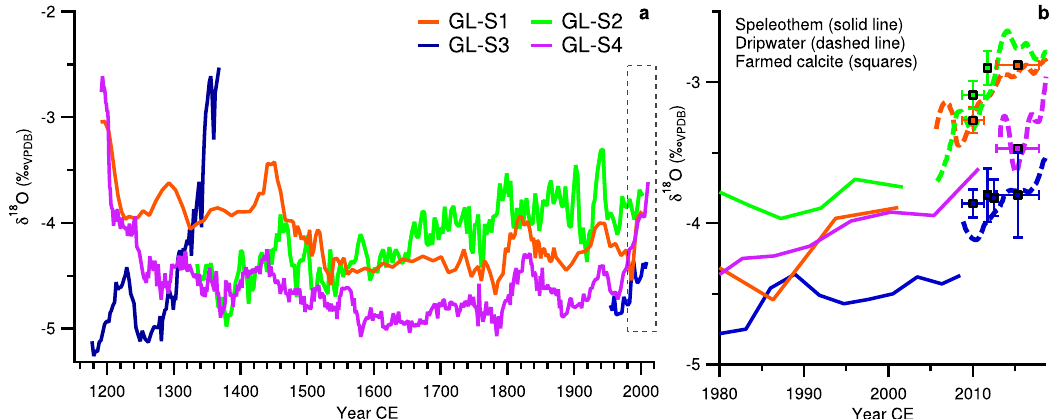
Fig. 4 Golgotha Cave speleothem δ 18 O records. a Speleothem records GL-S1 (red), GL-S2 (green), GL-S3 (navy blue) and GL-S4 (purple) for the last 800 years. b Comparison between speleothem (solid line), dripwater (dashed line) and farmed calcite (squares) for the last four decades. Dashed box in a indicates region re-plotted in b . Dripwaters were converted to calcite equivalent values using an empirical bulk fractionation factor derived from calcites farmed at the drip sites (Supplementary Note 1 and Table 1). Dripwater (calcite equivalent δ 18 O values) are used to extend the speleothem time series. The agreement (allowing for the rising trend) also supports the empirical fractionation factor calculated from Golgotha farmed calcites and